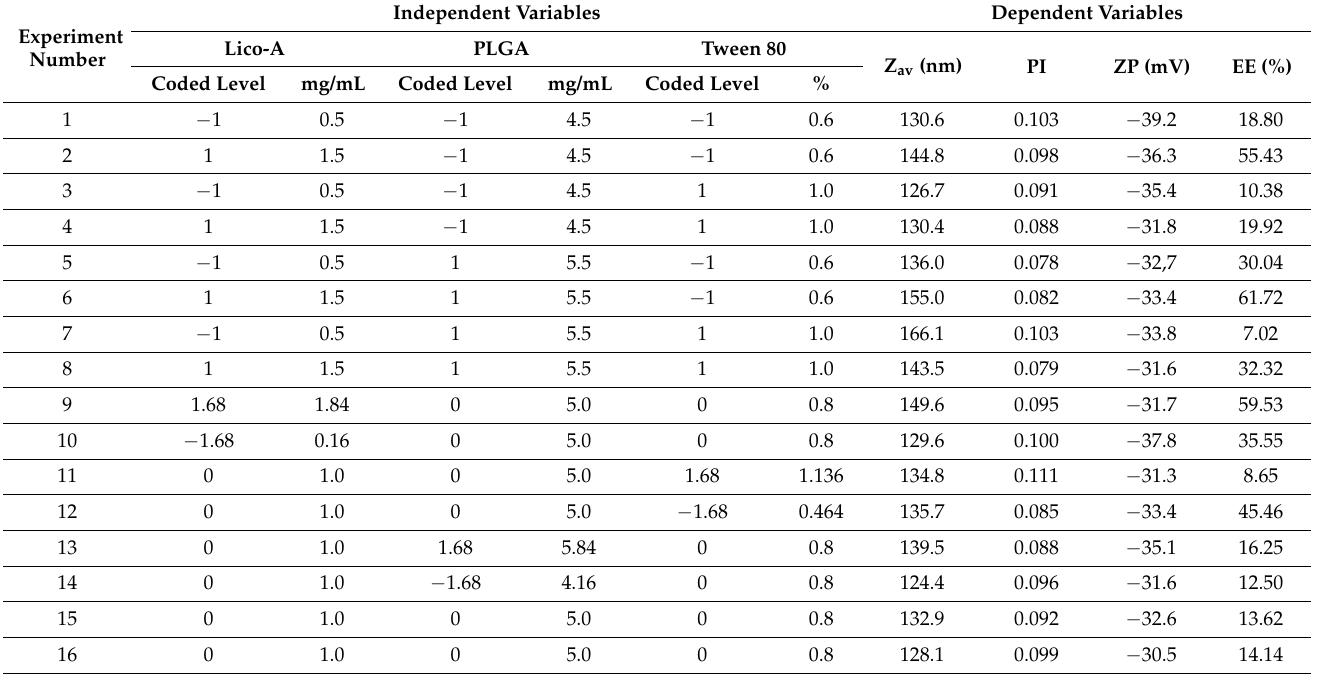
Table 2. Results of the factorial design developed to optimize Lico-A NPs